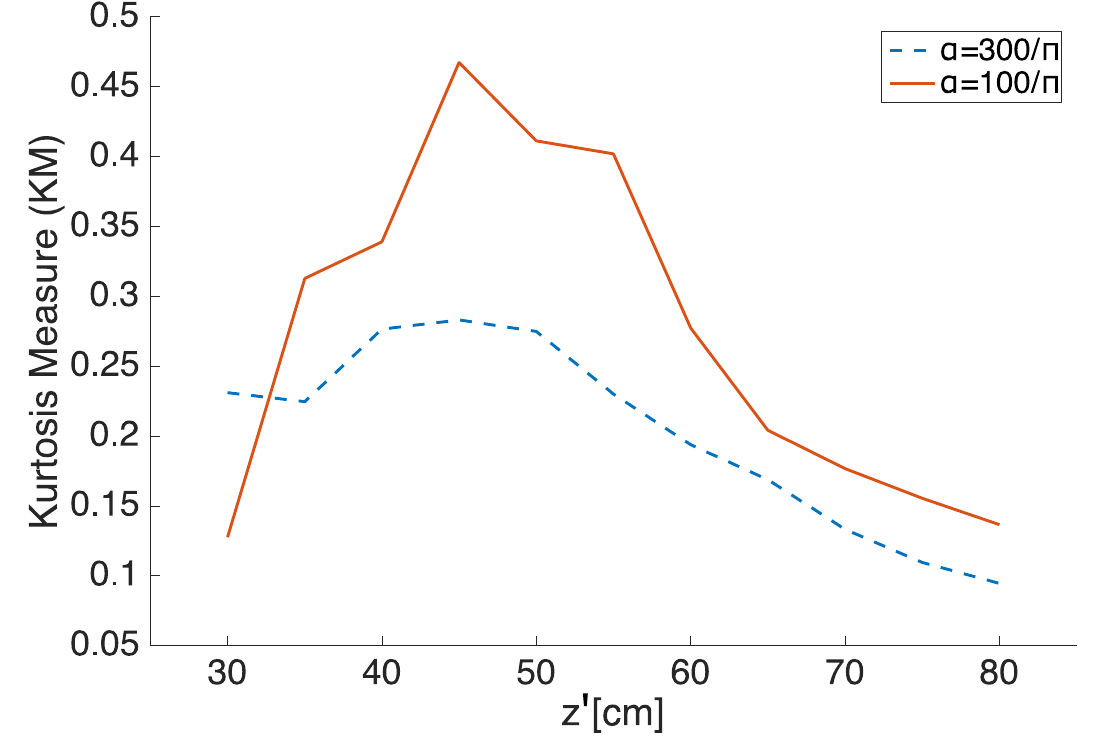
Figure 5. Kurtosis measure of the PSFs of the combined APM + FL imaging system along the z’-image plane range.